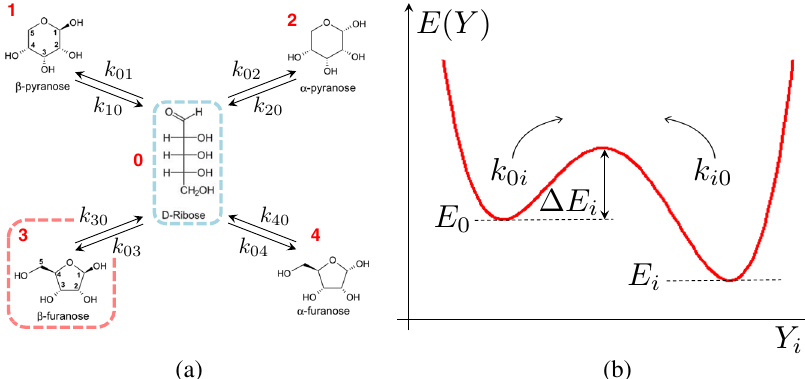
Fig. 1 Scheme of the D-ribose isomerisation reaction network and model energy landscapes. a The two pyranoses ( α and β ) and the two furanoses ( α and β ) are in equilibrium at a given temperature and pressure with the high-energy linear conformation. The rates of chemical transformations, k ij , are given by expressions (1). b Scheme of the Gibbs free-energy landscape along a representative reaction coordinate for the transition between the linear chain (energy E 0 ) and the i -th anomer (energy E i ) across the corresponding (unknown) energy barrier Δ E i . The energy of the linear conformation is the highest, i.e. E 0 > E i ∀ i 36 , corresponding to a population that is undetectable in solution via NMR measurements.